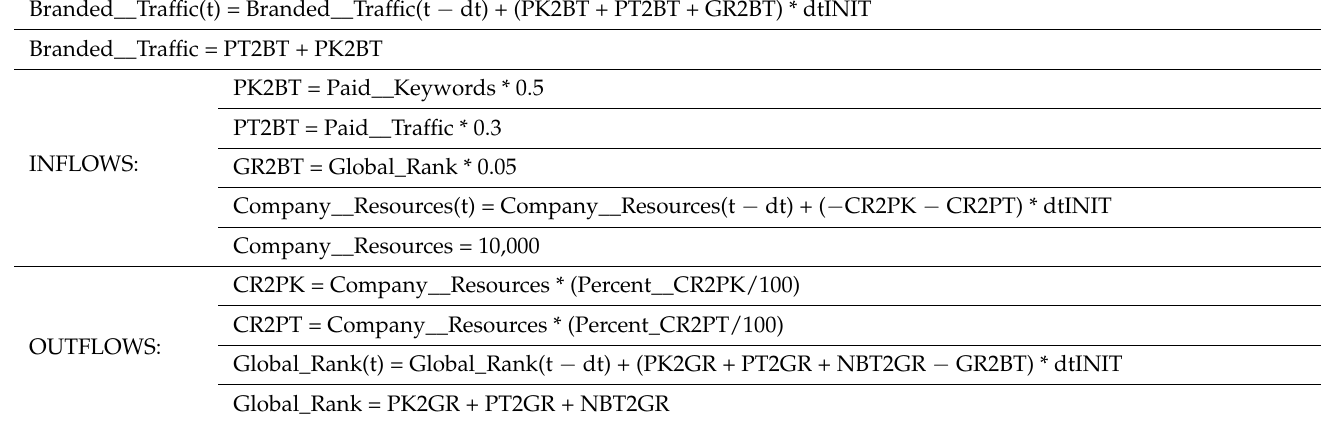
Table A1. iThink coding routine for defining branding through global